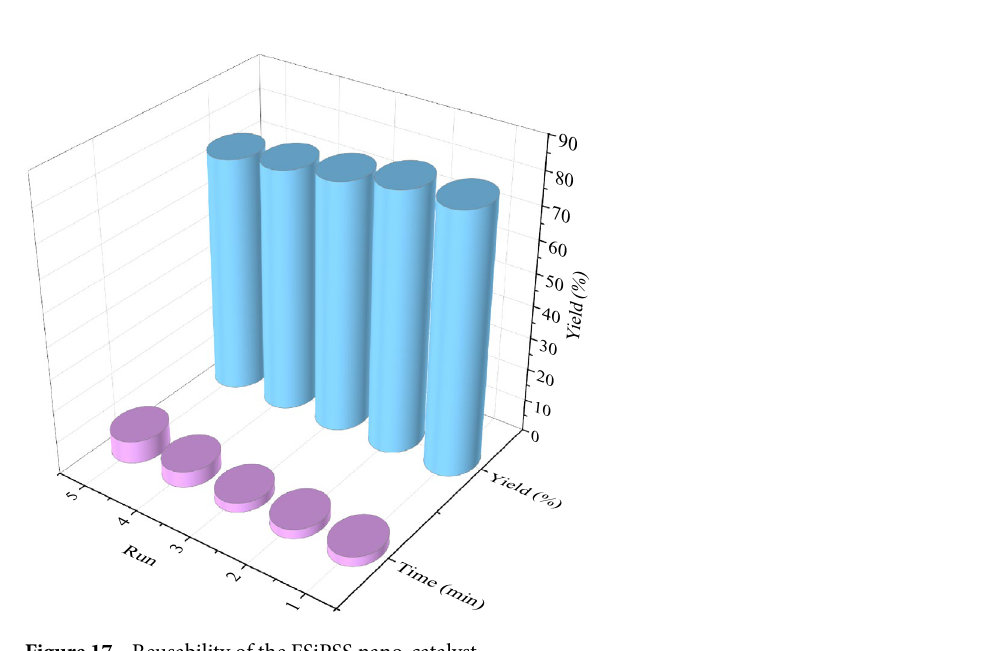
Figure 17. Reusability of the FSiPSS